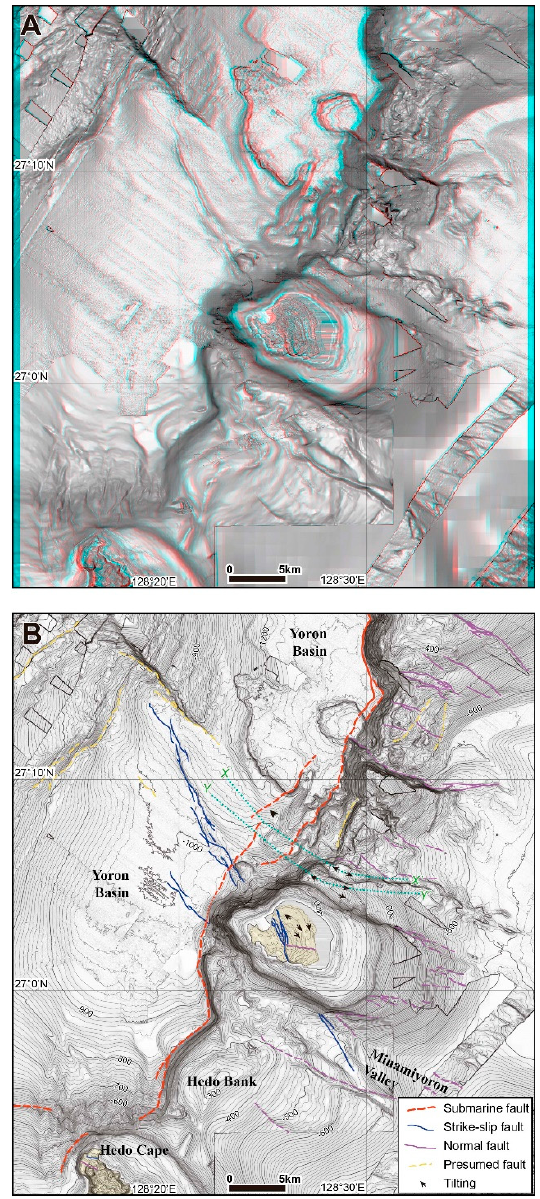
Figure 4. Topography around the Yoron island based on the 0.6-s-mesh DEM (approximately 19 m) from the National Institute of Advanced Industrial Science and Technology (AIST), the 2-s-mesh (approximately 65 m) from the Japan Agency for Marine-Earth Science and Technology (JAMSTEC), the 2-s-mesh (approximately 65 m) DEM processed via digital bathymetric charts (M7020) from the Japan Hydrographic Association (JHA), the 500-m-mesh DEM (J-EGG500) from the Japan Coast Gard (JCG), and the on-land SRTM-3 data provided by the United States Geological Survey (USGS). ( A ) Topographical Anaglyph. ( B ) Topographical map overlain with the active fault distribution.